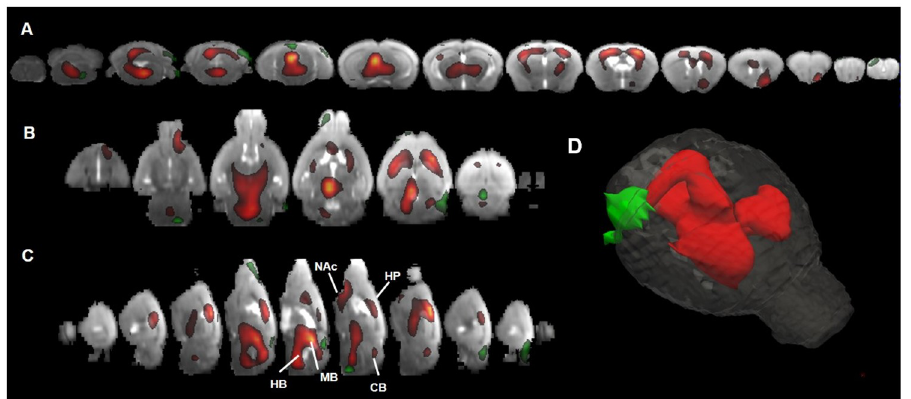
Fig 2. SPM results overlapped to an MRI scan template. The results are represented in axial (A), coronal (B) and sagittal (C) planes (p < 0.05, t-test, k = 25 neighbor voxels). (D) 3D-render of the results. Red color represents the areas with higher [18F]FDG uptake in darkness while green color represents the interaction area between illumination conditions and gender. NAc: nucleus accumbes; HP: hippocampus; MB: midbrain; HB: hidbrain; CB: cerebellum.